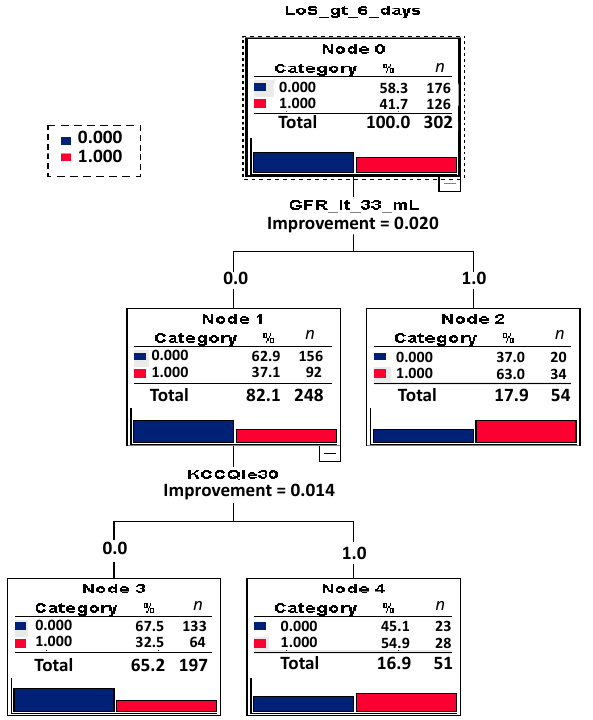
Figure 1. Decision Tree Algorithm for LoS > 6 days. Legend Figure 1. A decision tree is an algorithm that recursively divides the training data, based on certain splitting criteria, to predict a given target. This decision tree starts with all the participants in the root node (Node 0), then divides these participants into those with GFR less than 33 mL/min/1.73 m 2 , and those with GFR greater than or equal to 33 mL/min/1.73 m 2 ; for all participants with GFR less than 33 mL/min/1.73 m 2 , an additional separation was made between participants with KCCQ-scores greater than 30 and participants with KCCQ-scores lower than or equal to 30. LoS_gt_6_days = LoS greater than 6 days; GFR_lt_33_mL = GFR lower than 33 mL; KCCQle30 = KCCQ score lower than or equal to 30. In each node, 0.0 (zero) means that the participants within this node do not have the respective feature (e.g., GFR_lt_33_mL) and 1.0 means that the participants do have this feature. Depicted with blue (or 0.000) are participants with LoS equal or lower than 6 days and depicted with red (or 1.000) are participants with LoS > 6